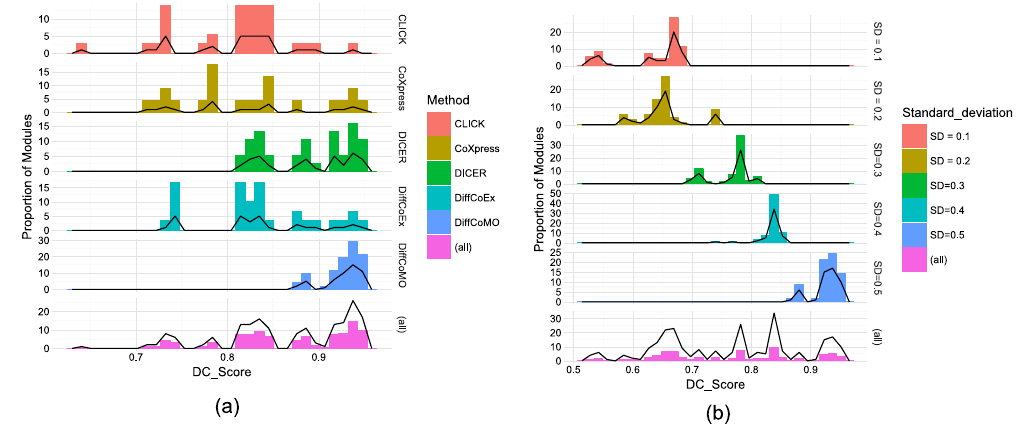
Figure 9. Panel (a) shows distributions of DC _ Score of the identified modules for different algorithms at SD value 0.5. Panel (b) shows the distribution DC _ Score of DiffCoMO modules at different SD